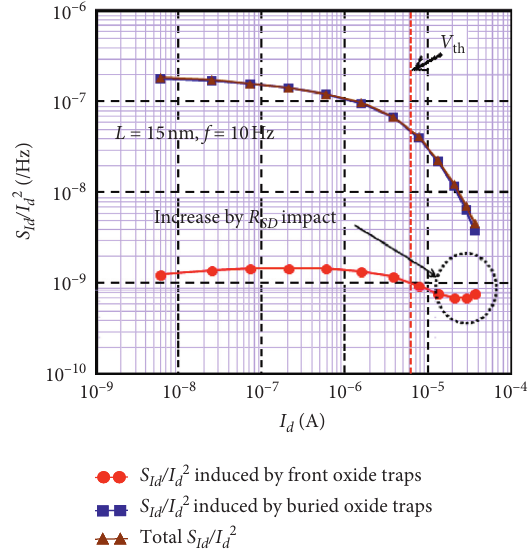
Figure 10: 2D numerical simulation of S (CNF+CMF+ Δ r )-based model, of front and buried oxide noise sources as a function of drain current for a gate length L � 985nm. The front gate operating mode is